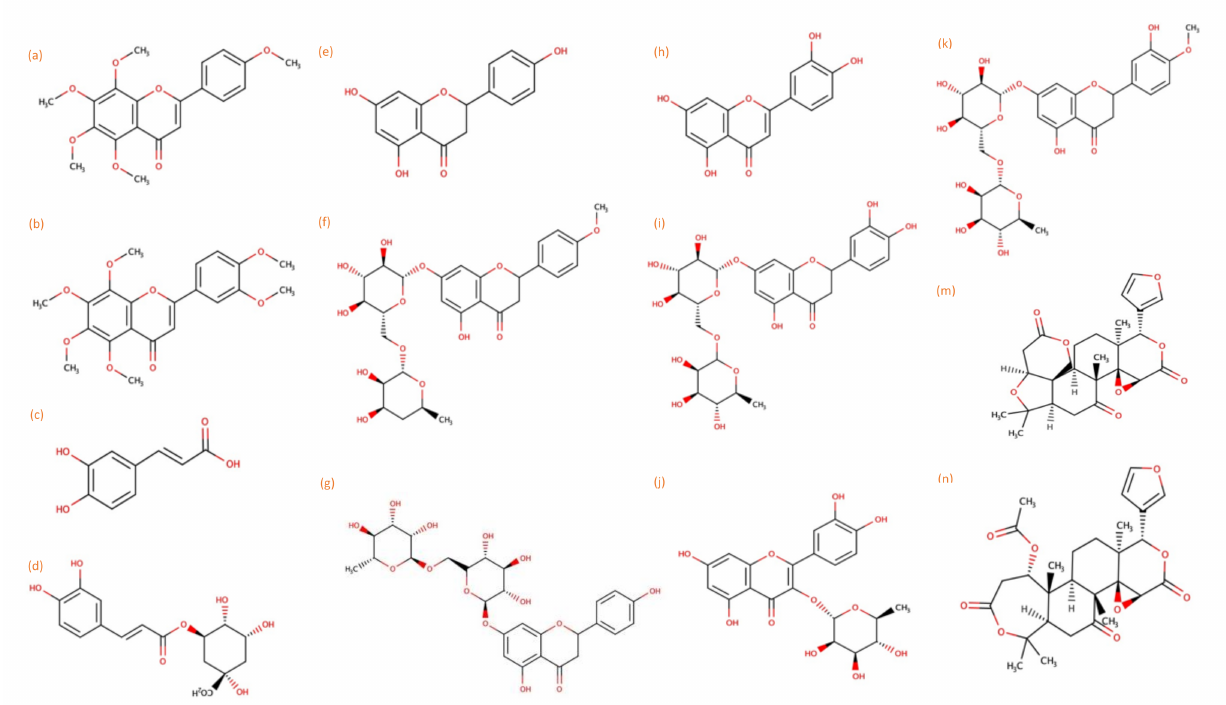
Figure 1. Structure and classification of polyphenols quantified in commercial varieties of mandarin leaves. Polymethoxyflavones, tangeretin ( a ) and nobiletin ( b ); hydroxycinnamic acids, caffeic acid ( c ) and chlorogenic acid ( d ); flavanones, naringenin ( e ), didymin ( f ), narirutin ( g ), eriocitrin ( i ), and hesperidin ( k ); flavone, luteolin ( h ); flavonol, quercitrin ( j ); and limonoids, limonin ( m ) and nomilin ( n ).